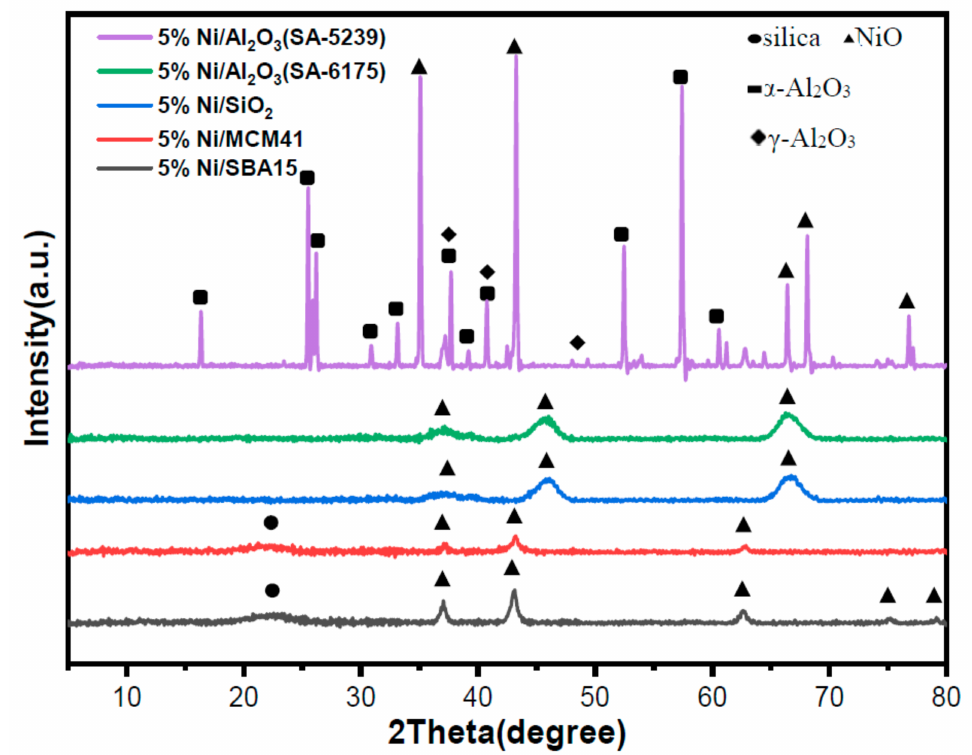
Figure 2. XRD patterns for the freshly calcined catalysts. (a.u.: arbitrary unit).